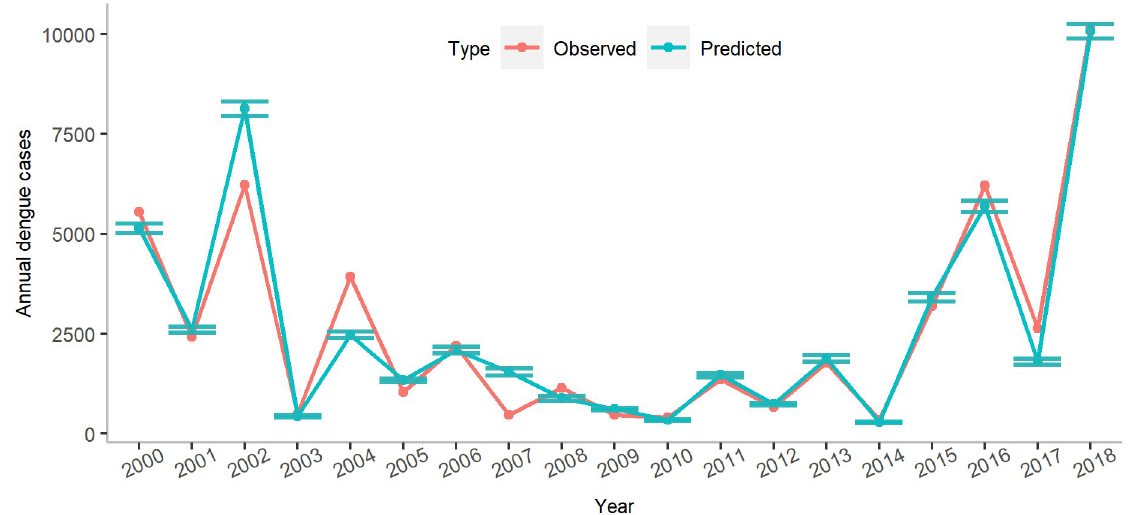
Fig 5. Comparison of observed and predicted annual dengue cases. The 95% confidence intervals were estimated using a bootstrap estimation technique and the LOOCV estimates.